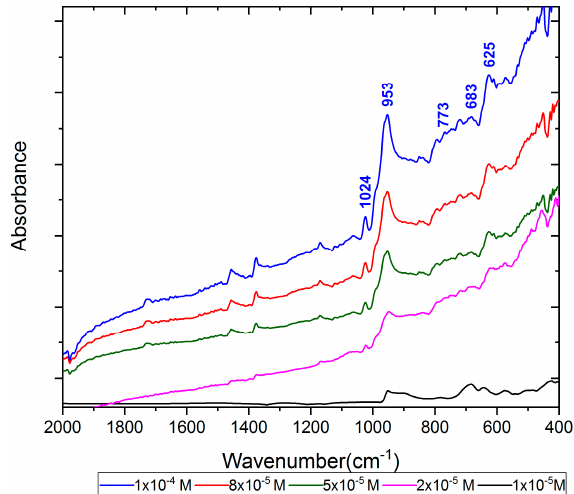
Figure 18. The DRIFT spectra of dithiophosphate adsorption on bornite with increasing collector concentration.